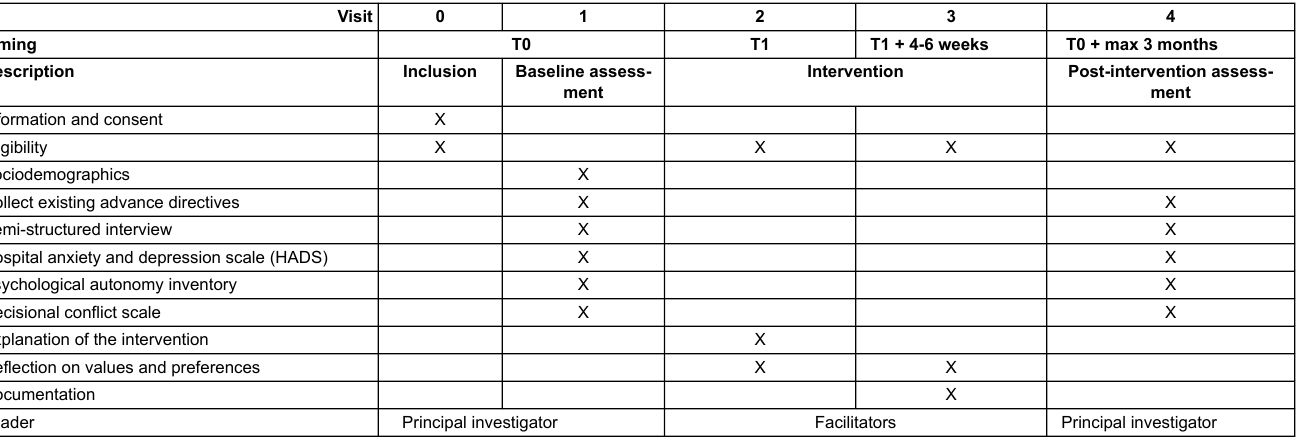
Table 3: ADIA pilot trial schedule and